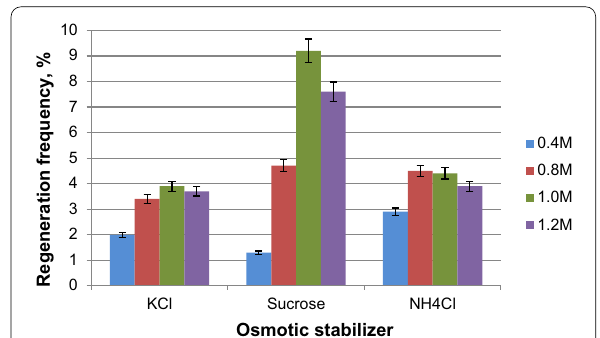
Fig. 4 Influence of different osmotic stabilizers on regeneration frequency of G. zeae